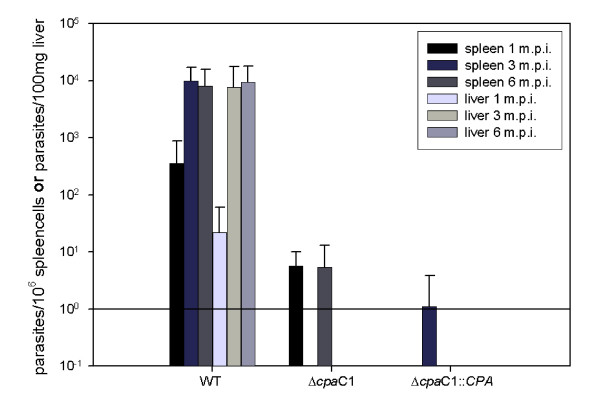
LiCPA mutant infectivity in vivo. Hamsters were infected with wild type (WT), CPA null mutant (ΔLicpaC1) or re-expresser clone (ΔLicpaC1::CPA) of L. infantum. The parasite burden in spleen and liver was determined by limiting dilution culturing at one, three and six months post infection (1, 3 or 6 m.p.i.). Results are shown as the average parasite burden per group; error bars indicate the standard deviation.